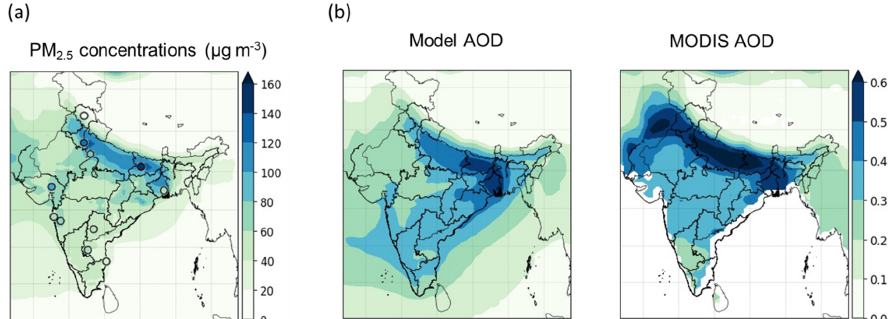
Figure 4. Model evaluation by (a) comparison of simulated annual mean PM 2 . 5 concentrations with in situ observations (circles represent observations) and (b) comparison of modelled annual mean AOD over India with observations from MODIS.